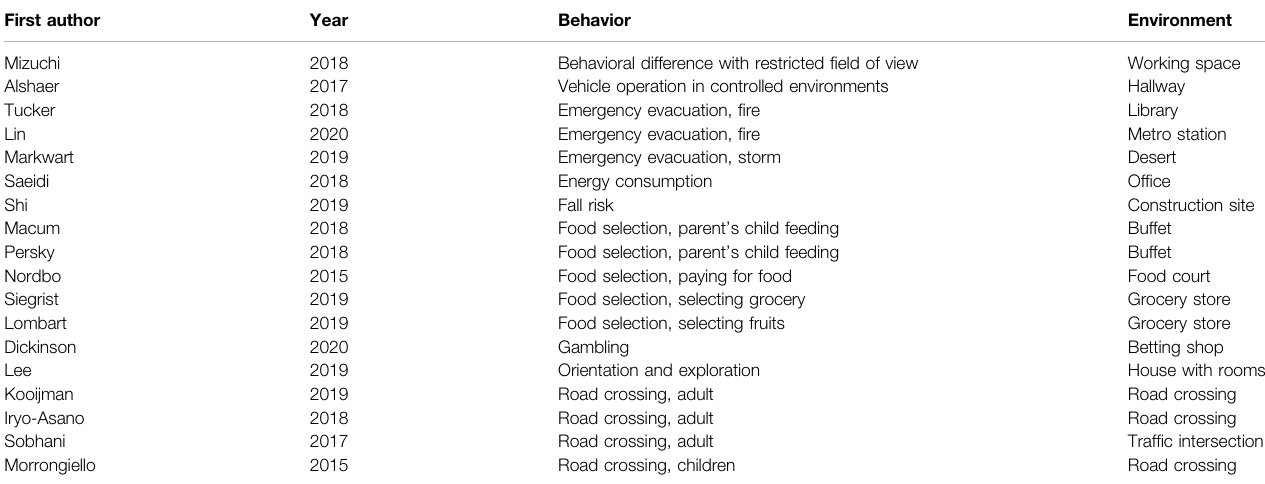
TABLE 3 | Types of behavior and